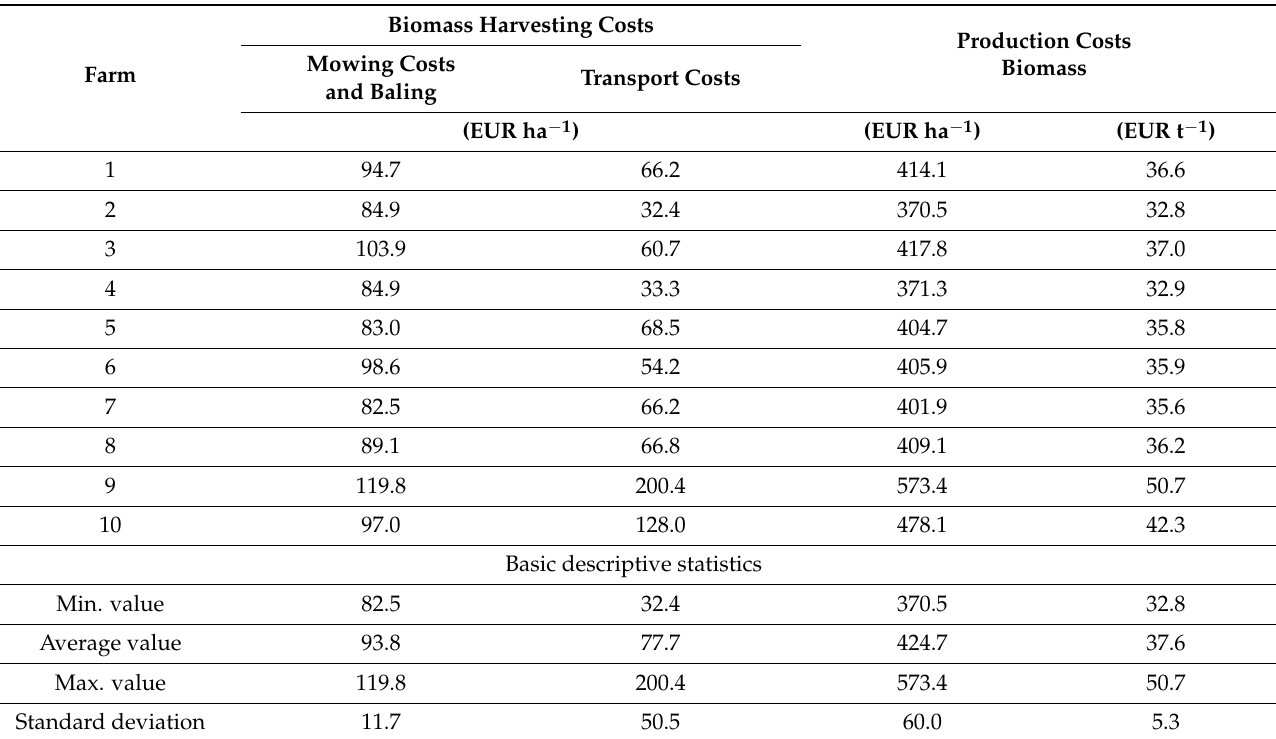
Table 7. Production costs of biomass from Miscanthus giganteus in the agricultural holdings under